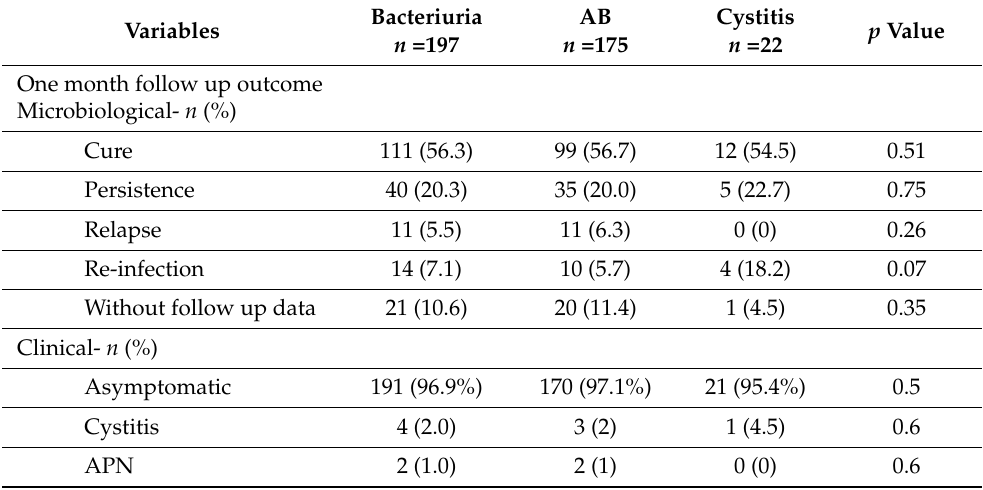
Table 2. Microbiological and clinical outcomes of the total events, asymptomatic bacteriuria and